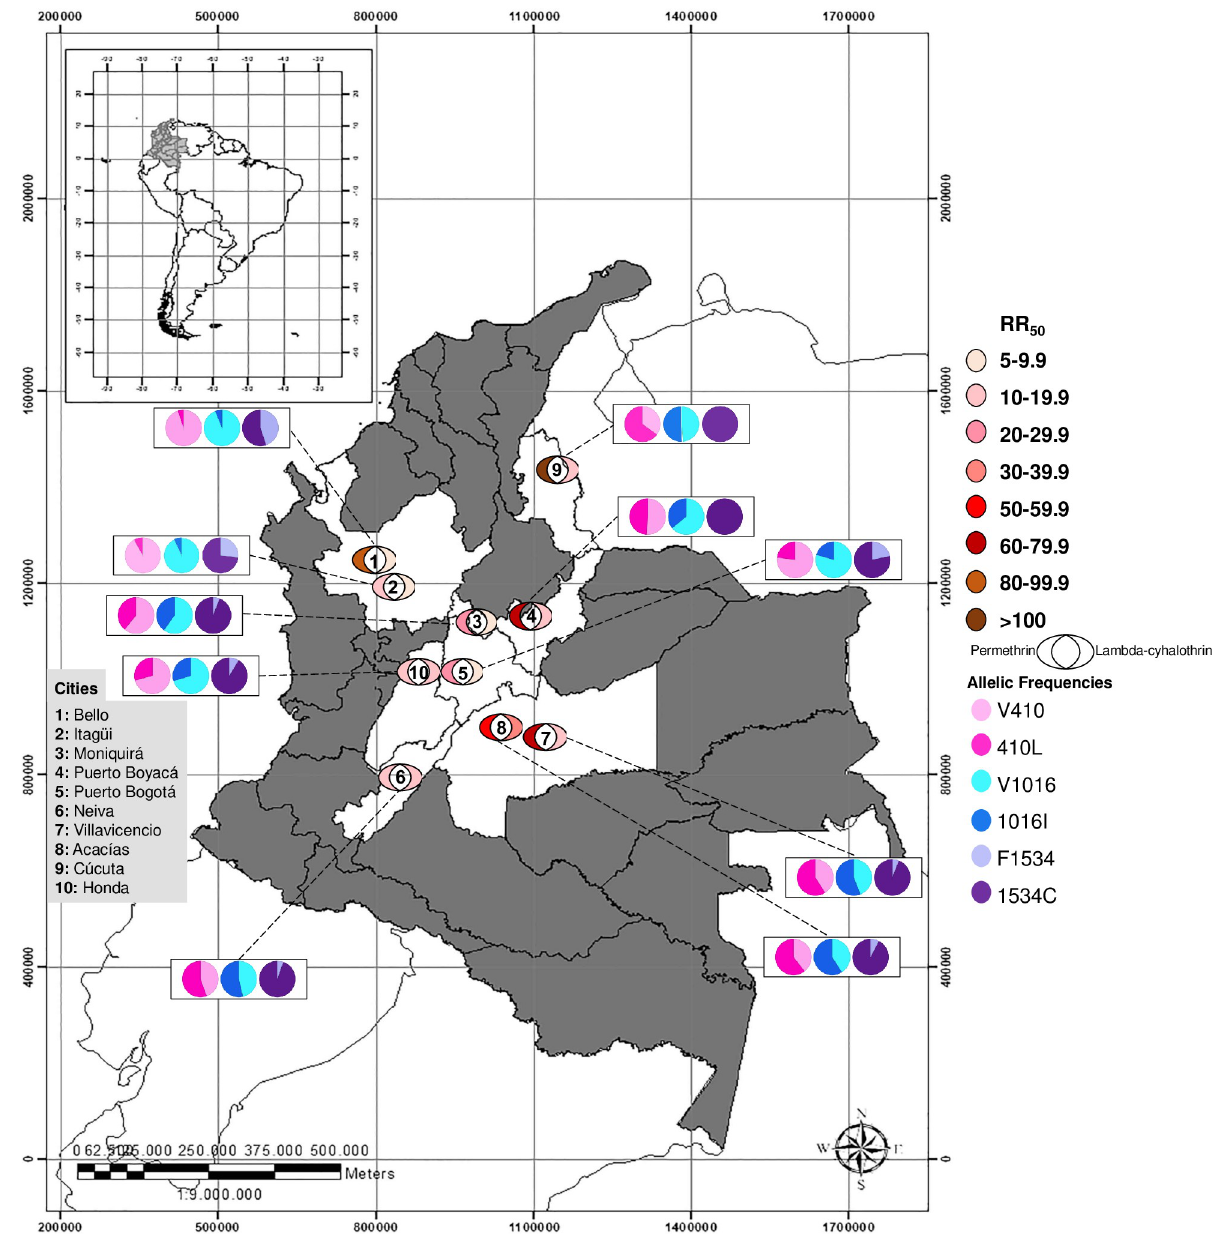
Fig 1. Colombian cities in which Aedes aegypti mosquitoes were collected. Numbers correspond to each city: 1. Bello, 2. Itagu¨ı´, 3. Moniquira´, 4. Puerto Boyaca´, 5. Puerto Bogota´, 6. Neiva, 7. Villavicencio, 8. Acacı´as, 9. Cu´cuta, and 10. Honda. For each city, the level of resistance (RR 50 ) to permethrin (to the left of the number) and lambda-cyhalothrin (to the right of the number) in comparison to the susceptible Rockefeller strain of mosquito is shown in the half-round; darker colors represent a higher degree of insecticide resistance. The distribution of the kdr alleles for the positions V410L (pink), V1016I (blue), and F1534C (purple) are shown for each city. Lighter colors represent the wt allele frequencies, and darker colors indicate the mutated allele frequencies. Shaped downloaded from http://tapiquen-sig.jimdofree.com., Carlos Efraı´n Porto Tapique´n.